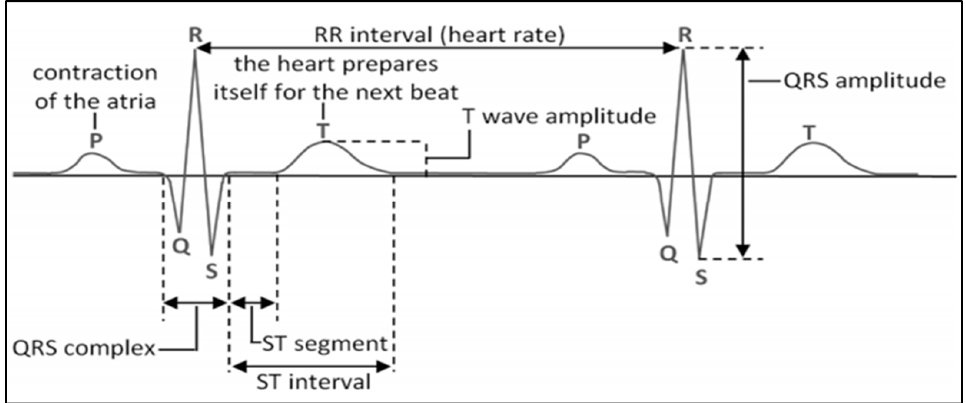
Figure 1. Key features of FECG [45] (Reprinted with permission from ref [45] Radek Martinek